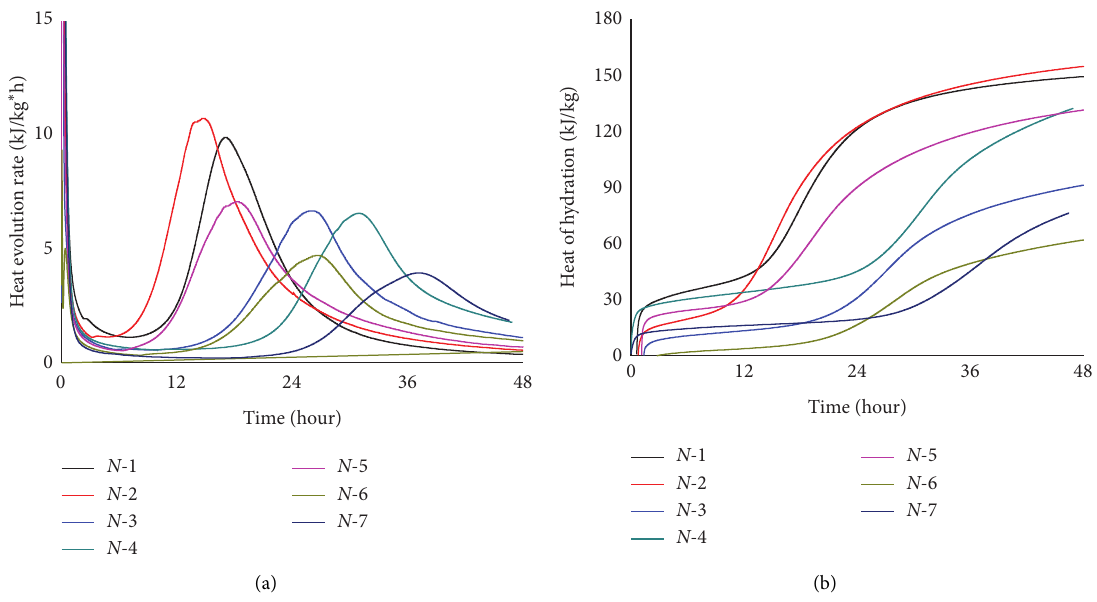
Figure 2: Effects of different cementitious compositions on the hydration heat of UHSC.